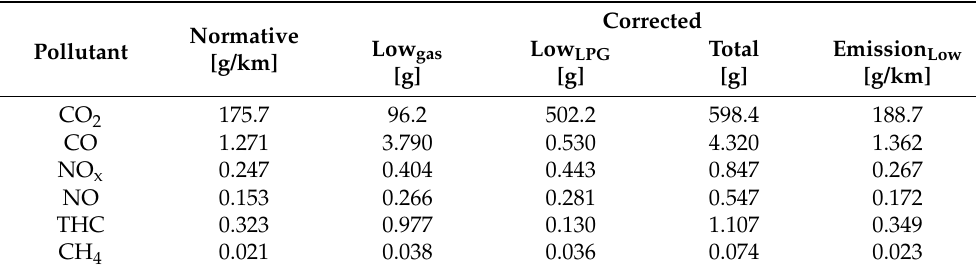
Table A1. Comparison of exhaust emissions calculated by the normative and corrected method for the Low phase of the WLTC cycle—measurement No. 1.